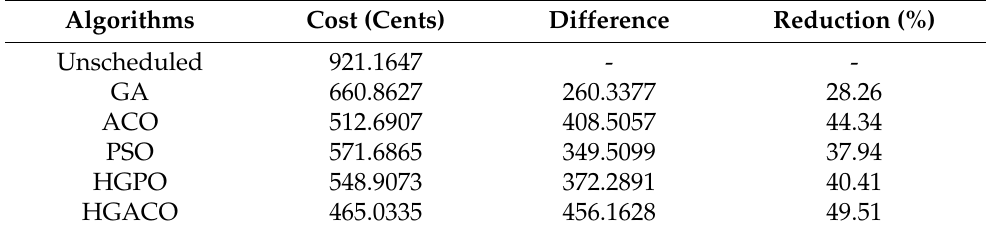
Figure 9. Electricity cost without photovoltaic-battery systems. Table 6. Scenario I: electricity cost assessment without photovoltaic-battery